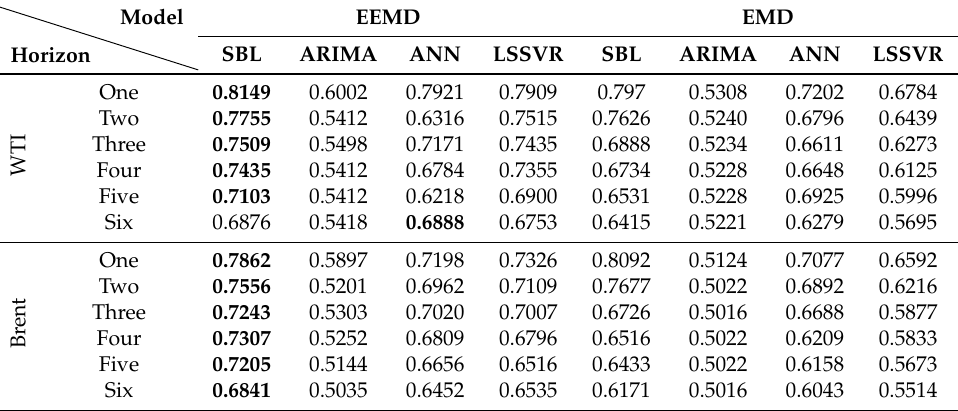
Table 9. The Dstat values by different ensemble models on WTI and Brent crude oil